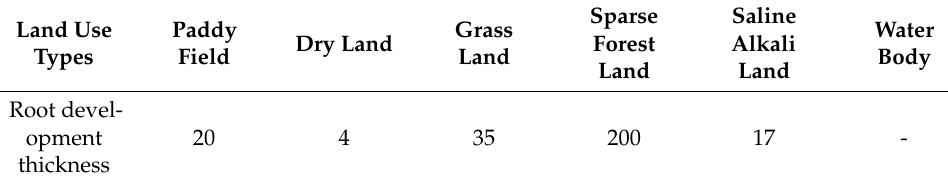
Table 3. Vegetation root development thickness of different land use